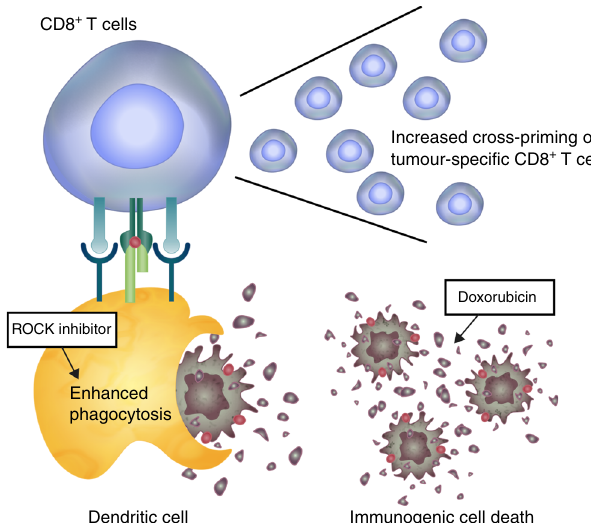
Fig. 8 Combined therapy triggers and propagates immunity against